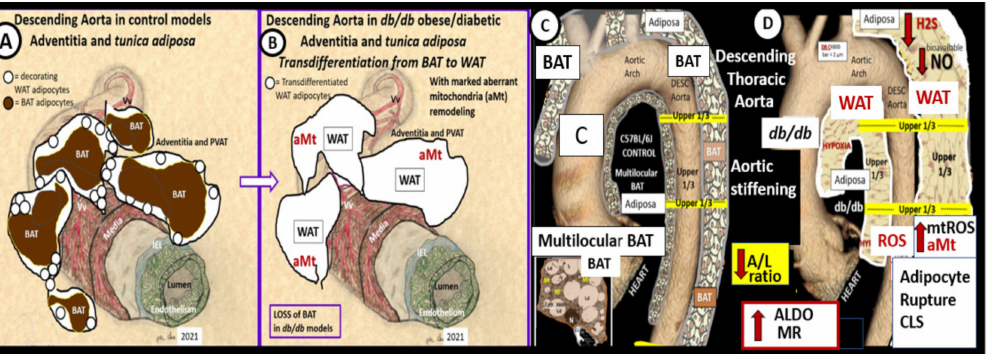
Figure 23. Transdifferentiation of the perivascular adipose tissue (PVAT) brown adipose tissue (BAT) of the descending thoracic aorta in control models to white adipose tissue (WAT) in the obese, insulin- resistant, diabetic db/db models. Panels A and B are hand drawn illustrations, while panels B and D depict images built around colorized MRI images of the aorta. Panels A and C demonstrate the normal BAT that envelops the healthy descending aorta in control models. Panels B and D depict the transdifferentiation of adipocytes from multilocular BAT in control models ( panels A and C ) to unilocular WAT in the obese, insulin-resistant, diabetic db/db models ( panels B and D ). This transdifferentiation from BAT to WAT of the PVAT is associated with the accumulation of aMt within the WAT adipocytes. These adipocytes become engorged and eventually rupture and develop crown- like structures associated with inflammation and loss of the PVAT protective functions, which result in aortic vascular remodeling and vascular stiffness in diabetic db/db models. Note that the aberrantly remodeled WAT in the obese diabetic db/db models ( panels B and D ) are associated with aMt, which are associated with increased mtROS, aldosterone (ALDO) and mineralocorticoid receptors (MR). Additionally, note the decrease in the adiponectin/leptin ratio (A/L) and the decrease in nitric oxide (NO) and hydrogen sulfide (H2S). These remodeling changes to the PVAT in the obese, diabetic db/db models results in the loss of the anticontractile and protective effects of the PVAT to the aortic vascular wall and promote remodeling vascular stiffening. The modified images in panels C and D are provided with permission from reference